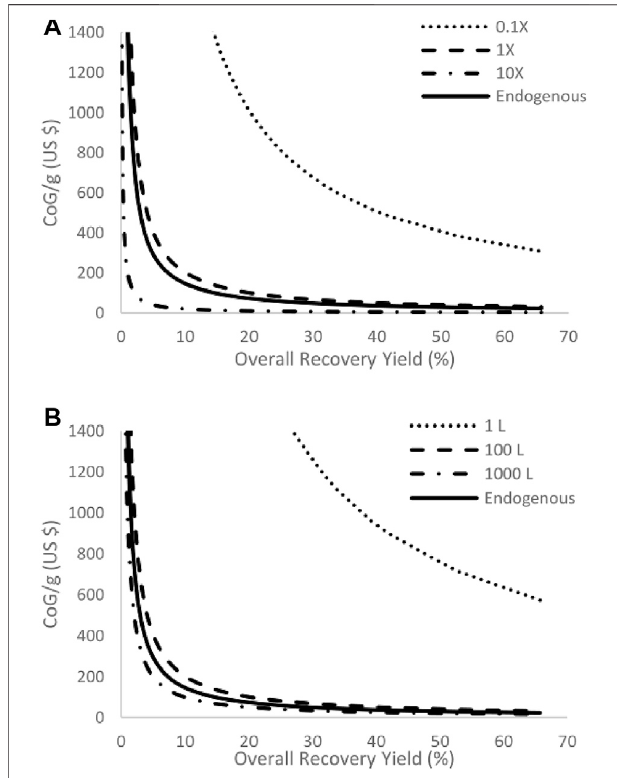
FIGURE3| Individualsensitivityanalysisresultsforproductiontiter (A) and bioreactor scale (B) at all the recovery yields analyzed. Results show a possible lower CoG/g for titer when optimizing this parameter. Alternatively, bioreactor scale can achieve higher CoG/g when reducing its operation